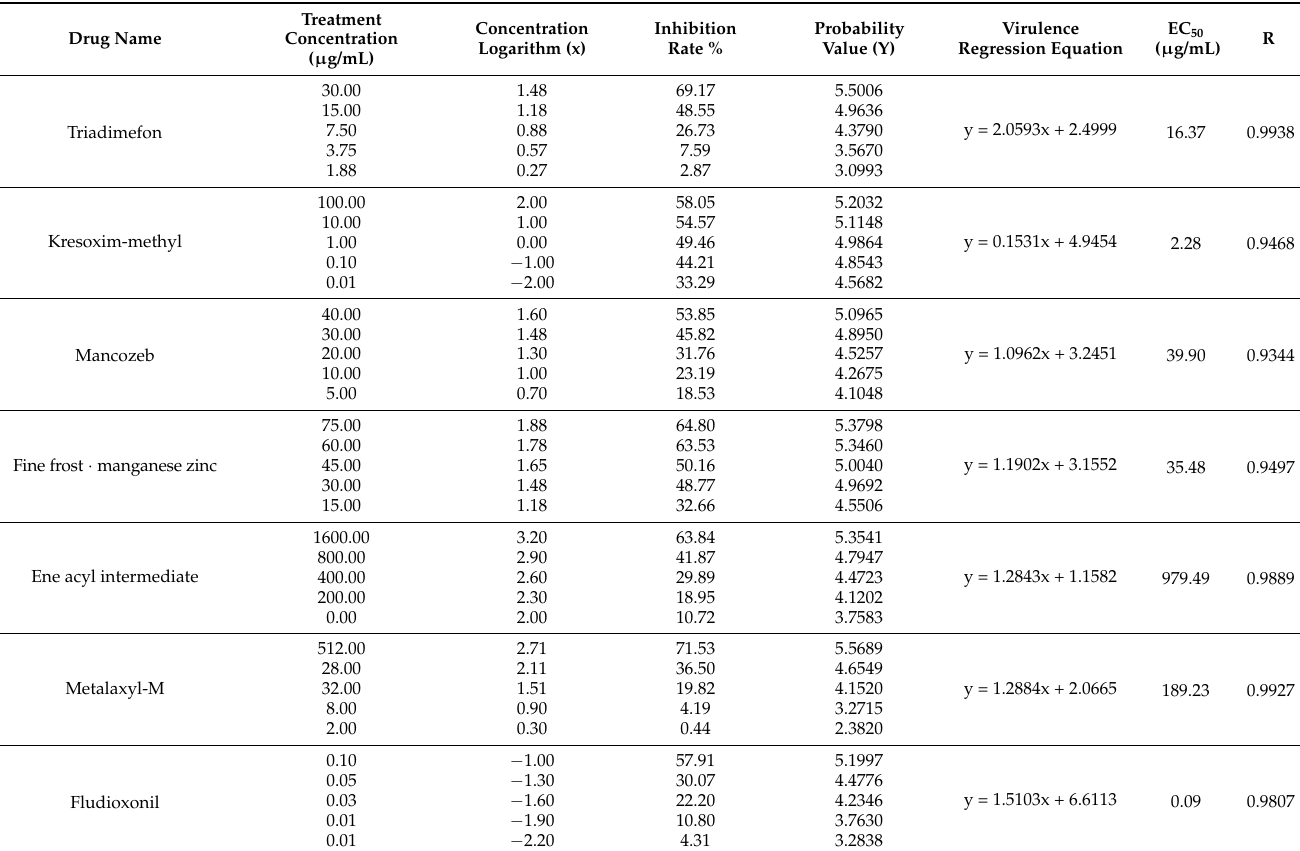
Table 4. Toxicity determinations of seven fungicides on mycelial growth of Fusarium on